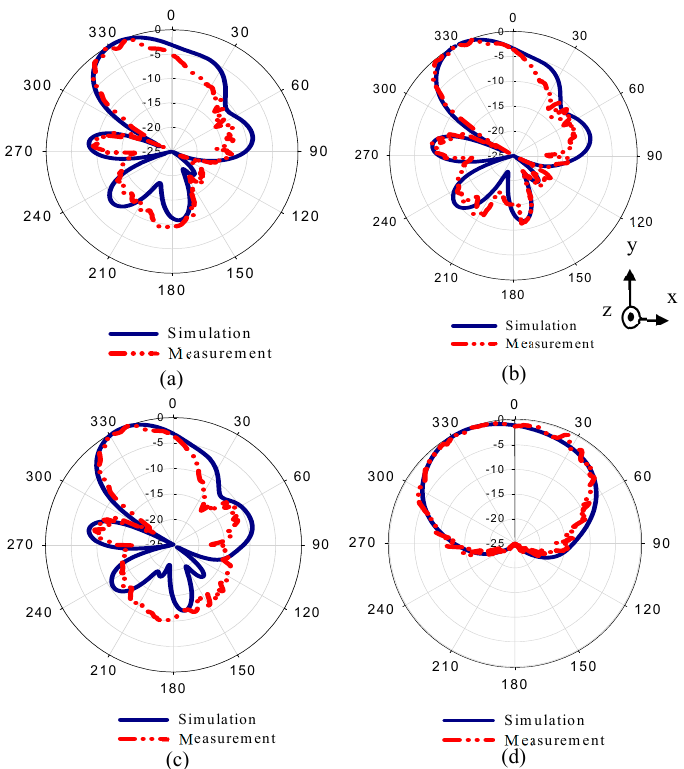
Figure 17. Normalized numerical and experimental radiation patterns of the dipole antenna embedded by two configurations of MM in E-plane (xy) at ( a ) 27.7 GHz, ( b ) 28 GHz, and ( c ) 28.3 GHz, and ( d ) in H-plane at 28 GHz.